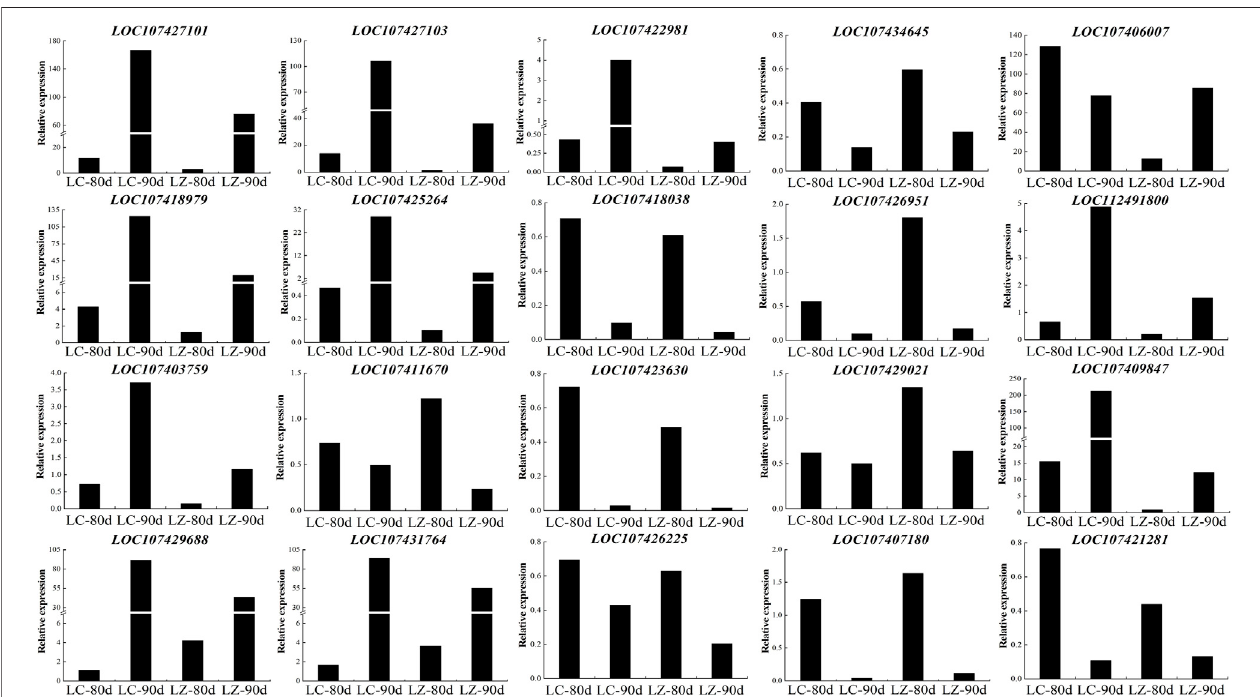
FIGURE 6 | Expression pro fi les of twenty randomly selected DEGs from LZ and its mutant LC jujube cultivars using real-time quantitative PCR.